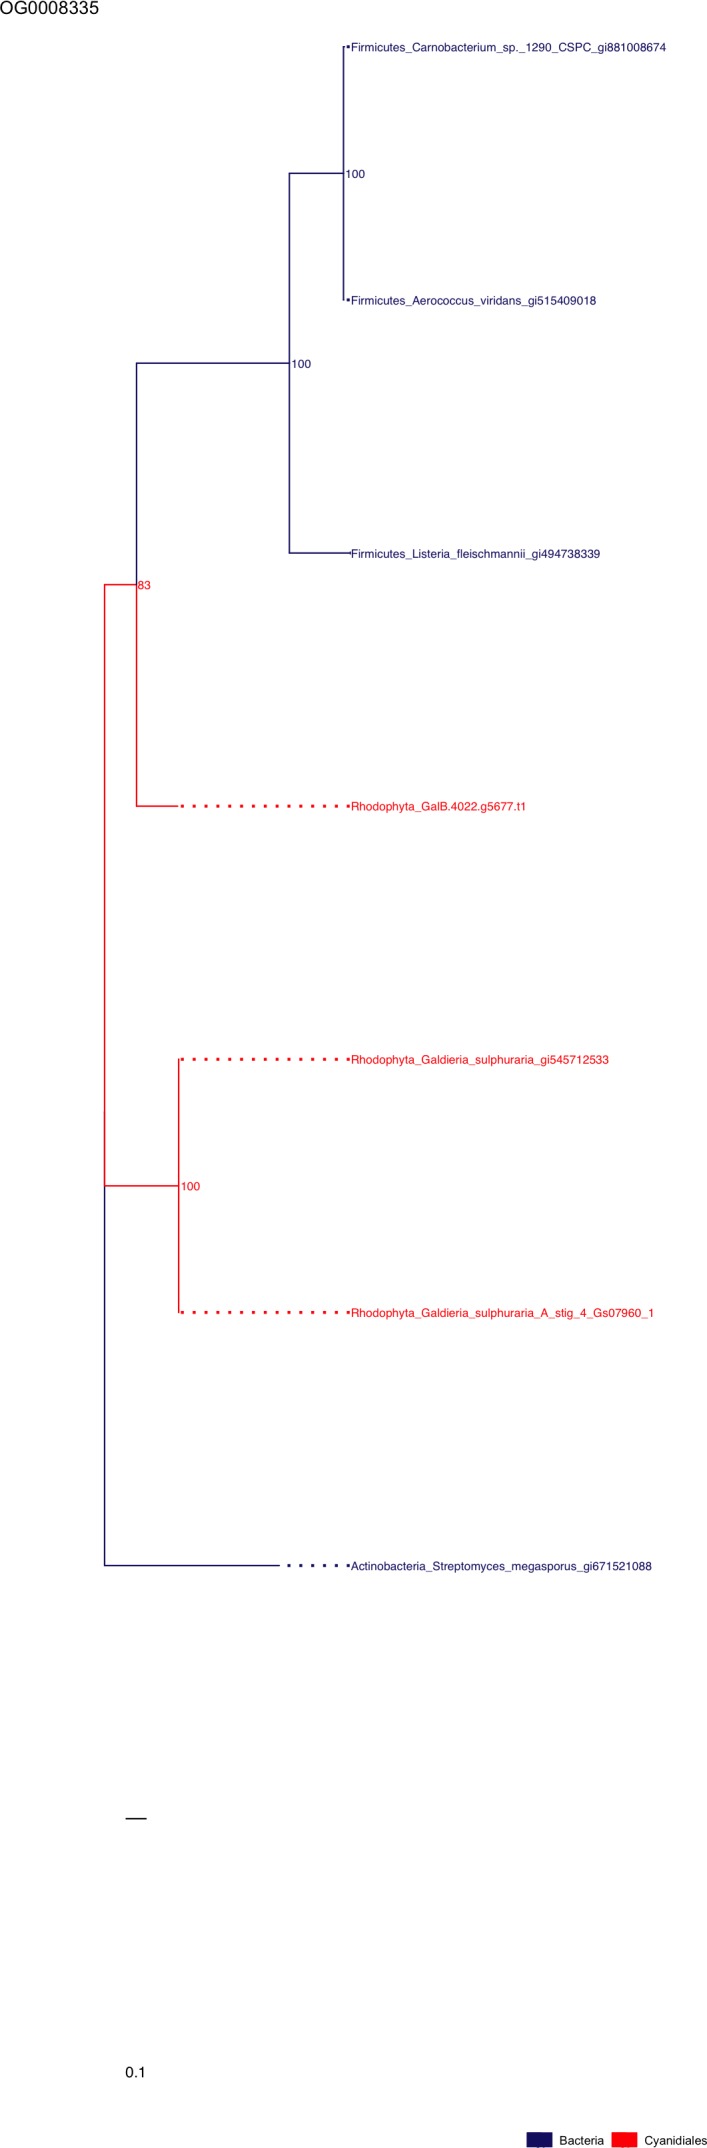
Sequence tree of orthogroup OG0008335.The tree is based on amino acid sequences. Archaea (yellow), Bacteria (blue), Cyanidiales (red), Eukaryotes including other red algae (green). Branches containing Cyanidiales sequences are highlited in red.